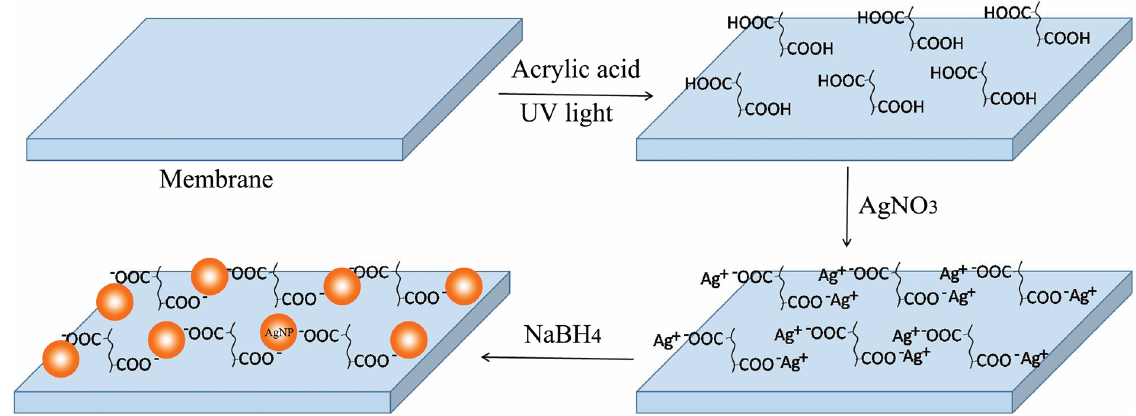
Table 1. Experimental conditions for the membrane